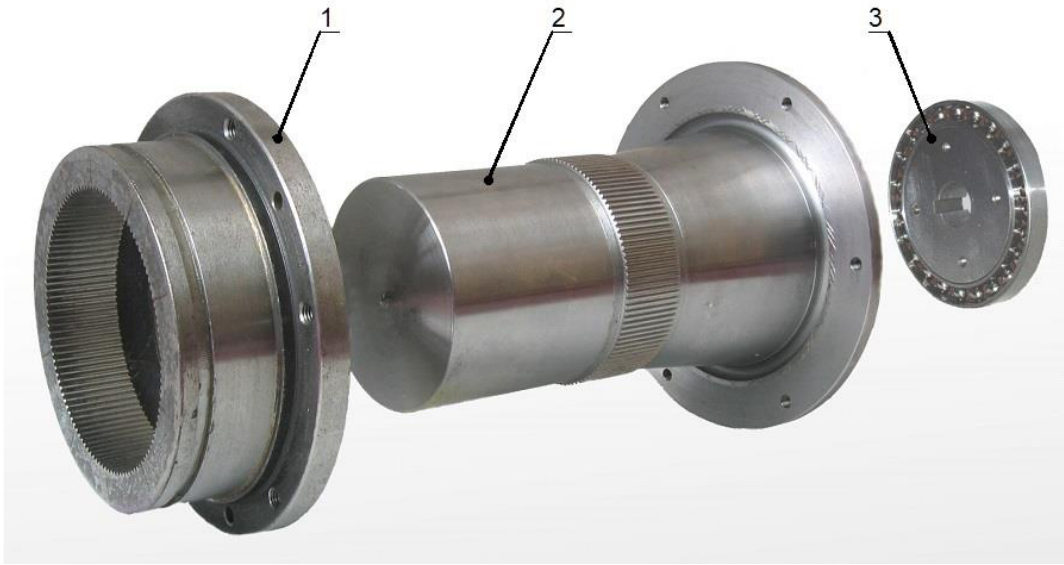
Figure 2. View of main component elements of hermetic harmonic drive: 1 — circular spline, 2 — flexspline, 3 — wave generator.